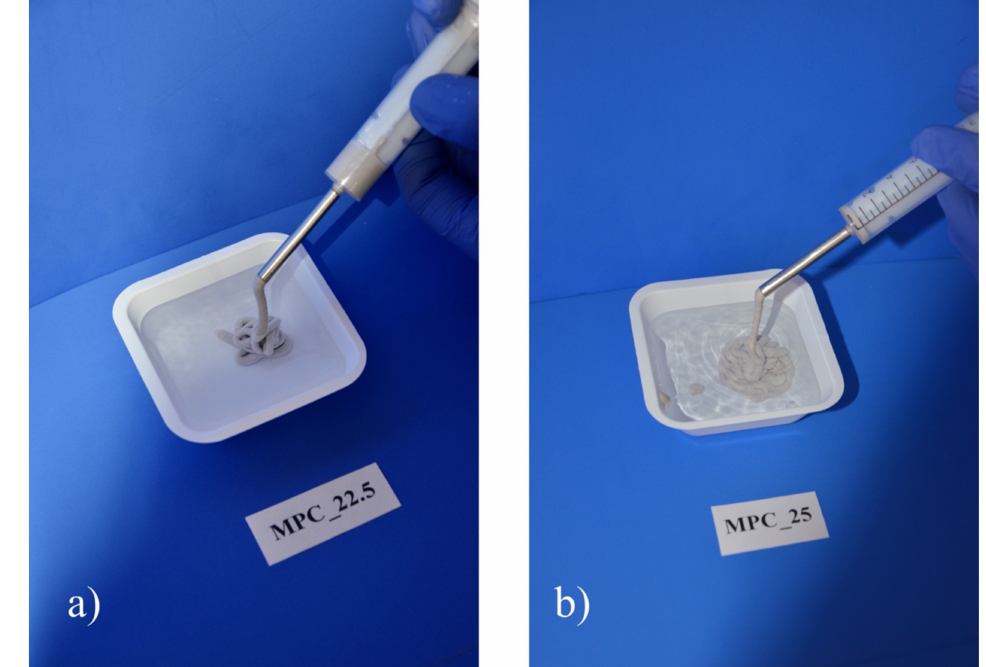
Figure 9. Cohesion test of the two MPC formulations. Full cohesion was achieved for both formula- tions, as neither ( a ) MPC_22.5 nor ( b ) MPC_25 showed streaks at the water surface when injected into deionized water.